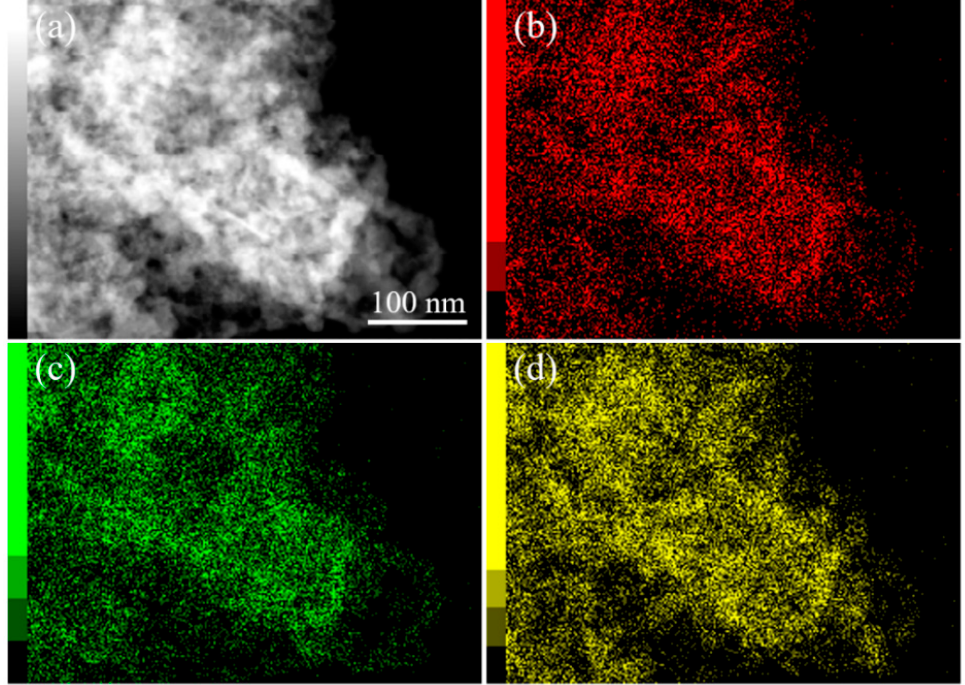
Figure 5. ( a ) HAADF-STEM image and ( b – d ) the corresponding elemental mapping (( b ) oxygen, ( c ) copper, and ( d ) nickel) images of Cu-Ni_0.20_300.